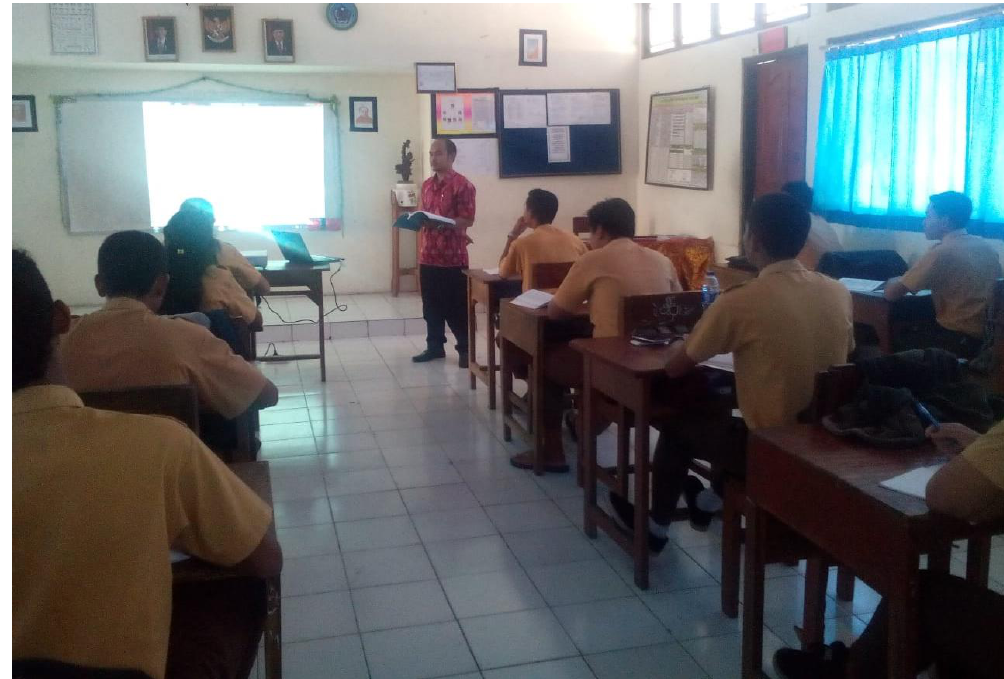
Figure 2. Learning at SMAN 1 Baturiti Tabanan